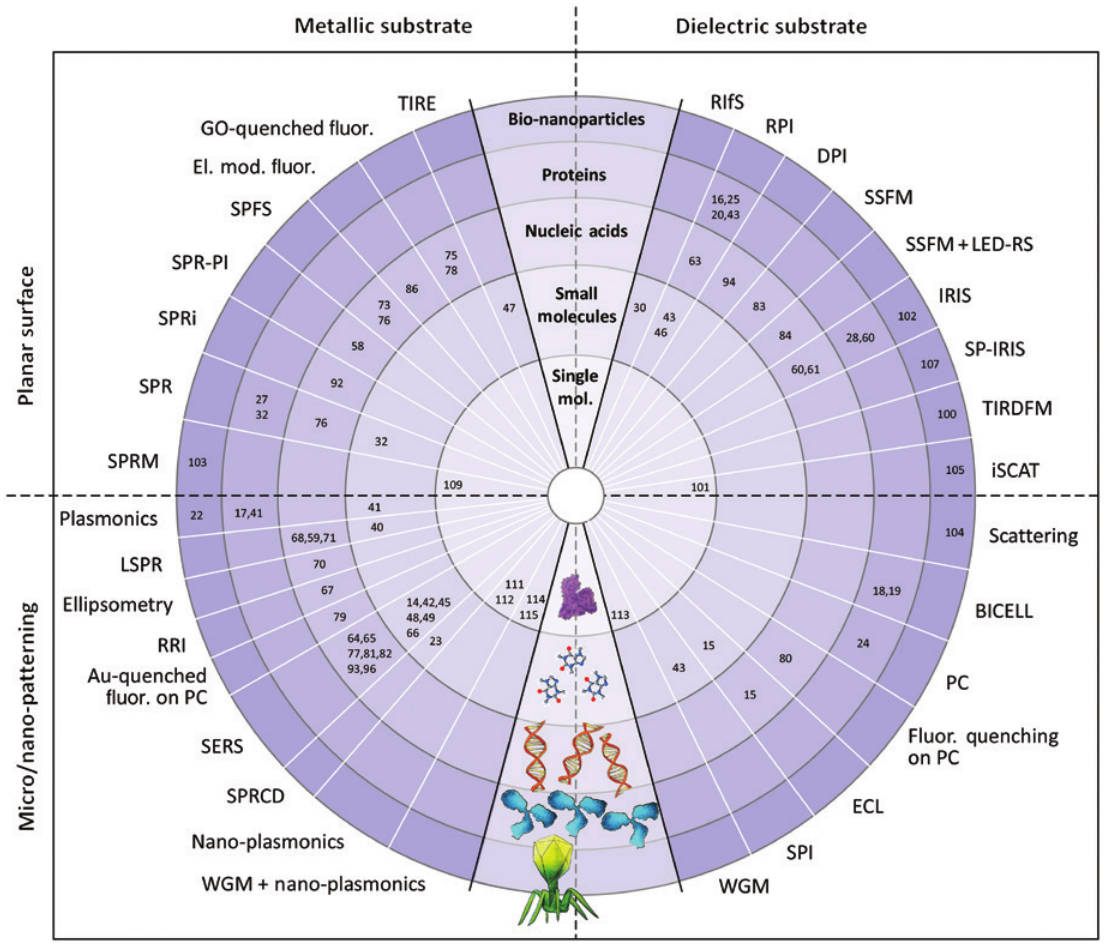
Figure 1: Graphical table reporting the biosensing methods and the corresponding references considered in this review. The references are placed in the graphic according to the type of sensing substrate and the type of target. References to works where a metallic (dielectric) substrate is used are reported on the left (right) half of the table. References to works adopting a nano- or micro- patterned (planar) sensing surface are reported on the lower (upper) half of the table. The position along the radial direction indicates the target type among bio-NPs, proteins, NAs, small molecules, and single